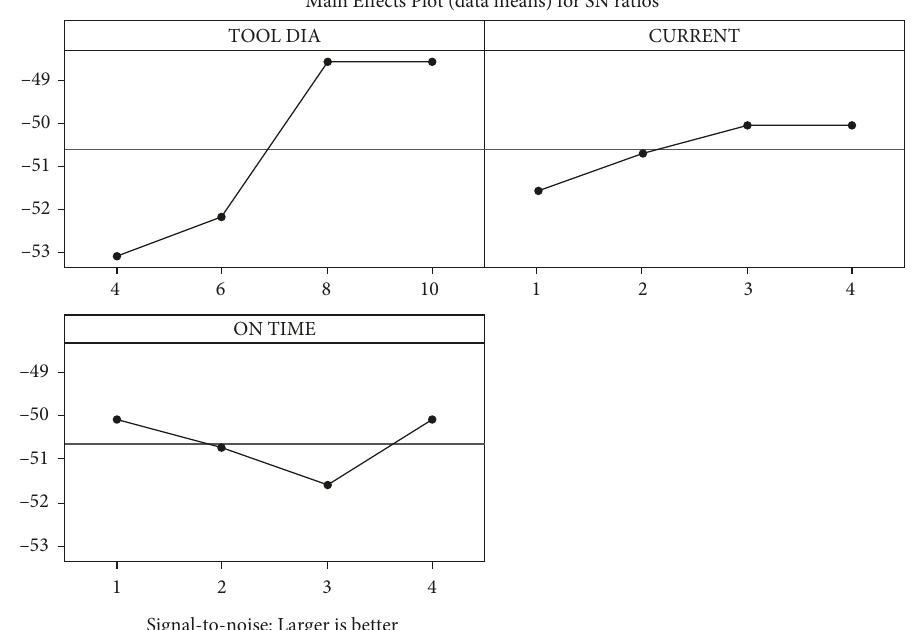
Figure 12: Main effect plot for SN ratio